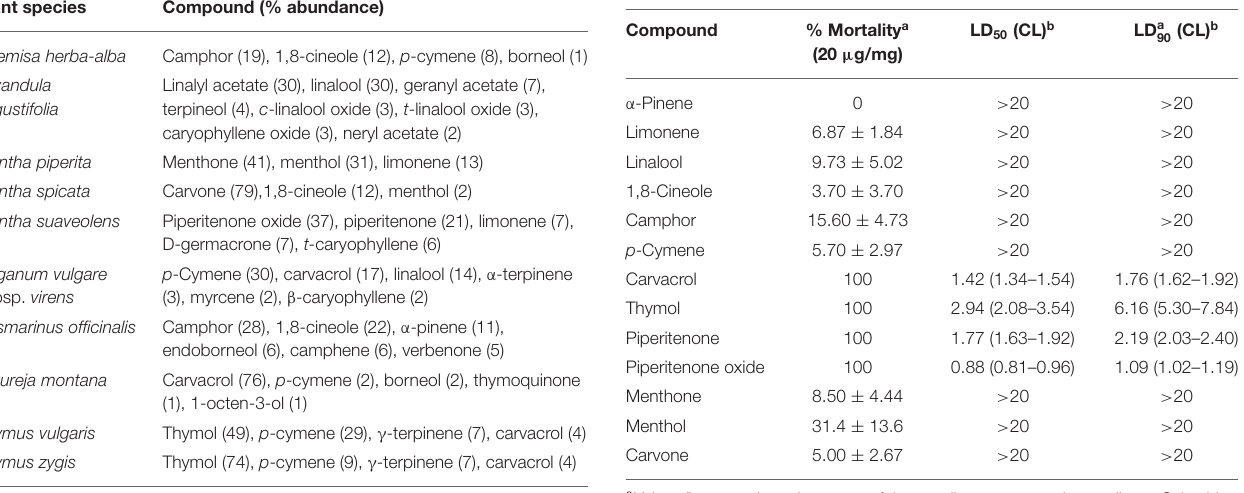
TABLE 6 | Ixodicidal activity of the main components (% abundance > 10) of the active essential oils on Hyalomma lusitanicum